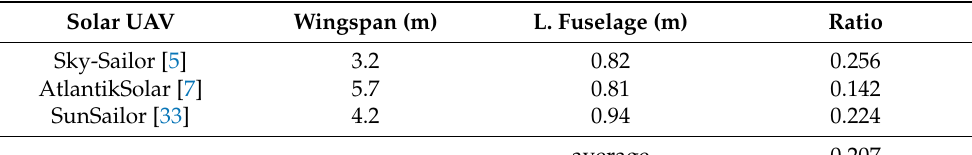
Table 2. Ratio of fuselage length to